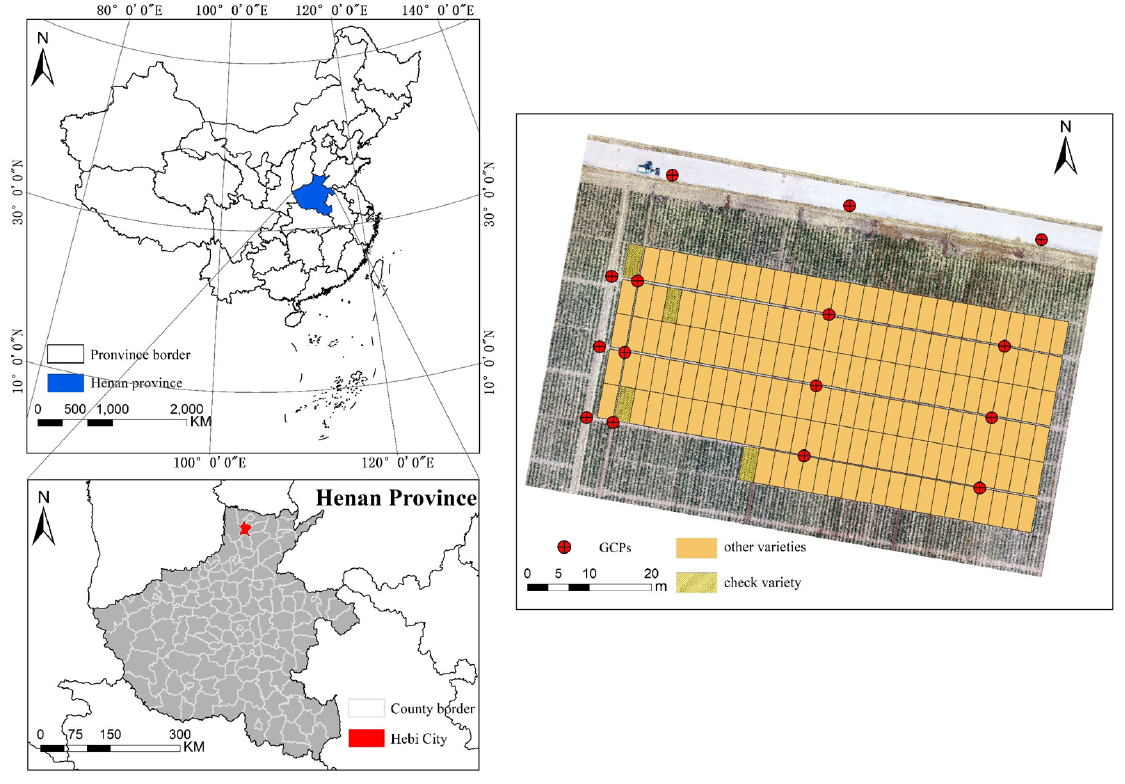
Figure 1. The layout of experimental